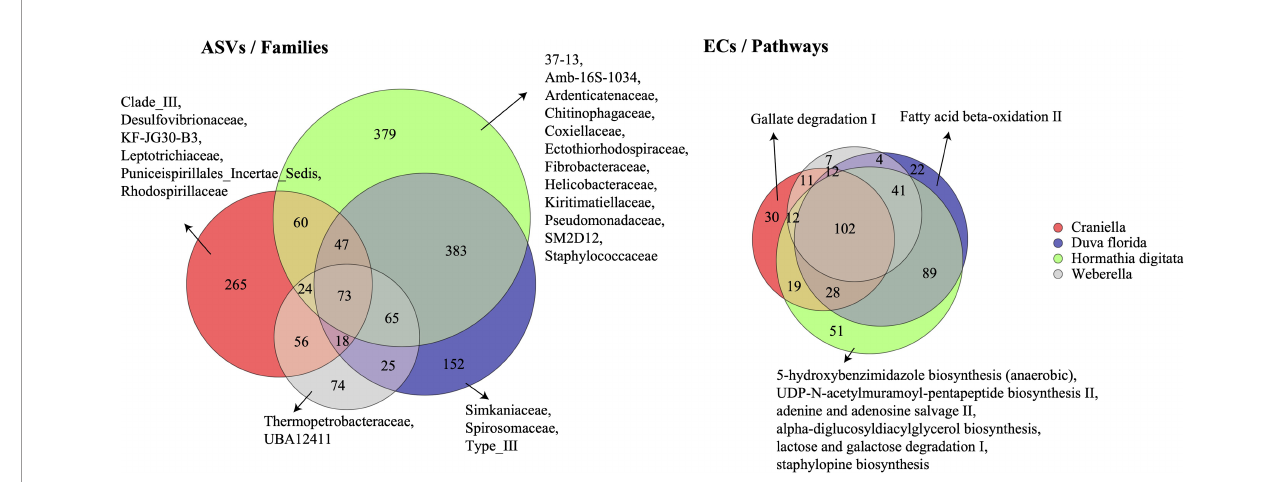
FIGURE 4 | Venn diagrams of the shared bacterial taxonomic (ASVs) and functional (ECs) communities between epibenthic taxa. Families and pathways unique to each taxon are also displayed. ASVs, Amplicon Sequence Variants; ECs, Enzyme Commission